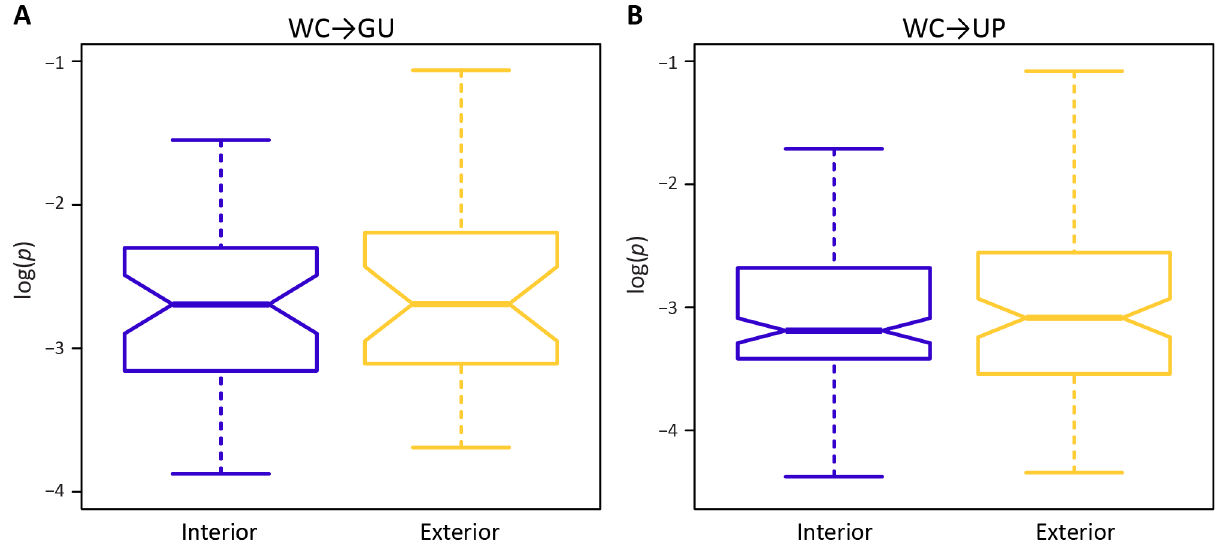
Figure 2. Intra-population frequencies of single-site WC replacement polymorphisms at interior and exterior stem positions. A ) Frequencies of WC R GU polymorphisms. B ) Frequencies of WC R UP polymorphisms. Frequencies are normalized to enable comparisons among classes (see Materials and Methods for details) and plotted on a log 10 -scale. Asterisks indicate p , 0.05 (*), p , 0.01 (**), and p , 0.001 (***). doi:10.1371/journal.ppat.1004363.g002 PLOS Pathogens |